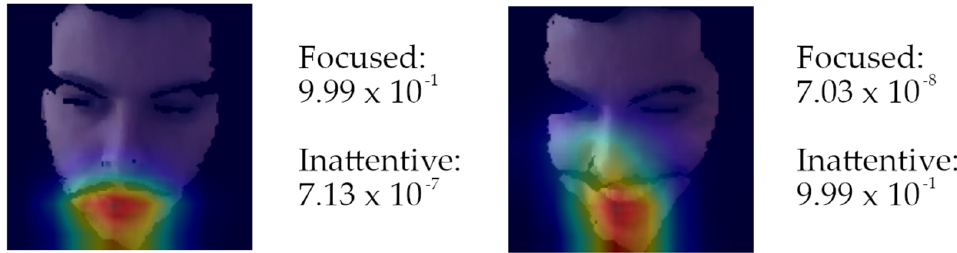
Figure 4. Predictions and activations analysis of two different frames. These images show the class activation maps of CNN using the Grad-CAM algorithm highlighting the important regions in the image for the result prediction [38].